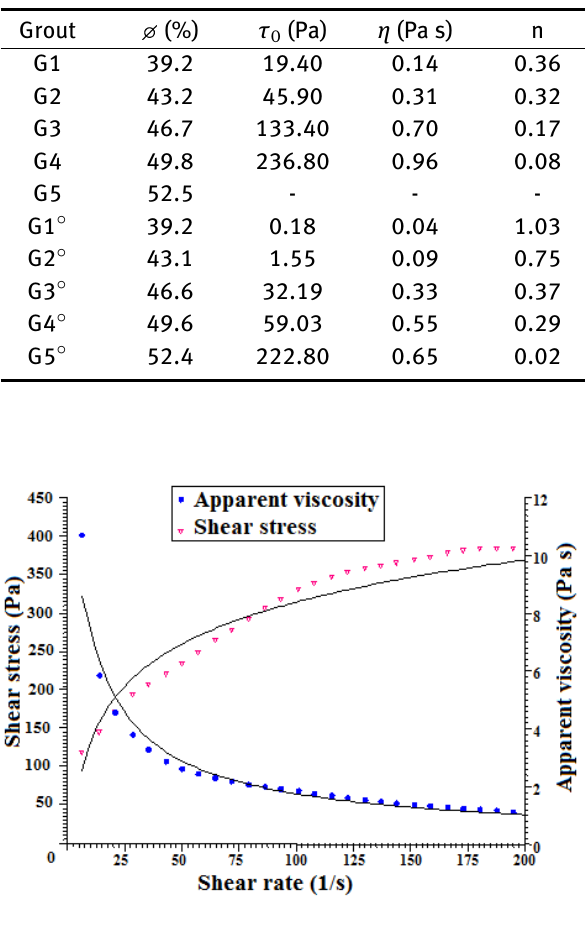
Figure 17: Evolution of the shear stress and the apparent viscosity with shear rate of the cement grout G4 ∘